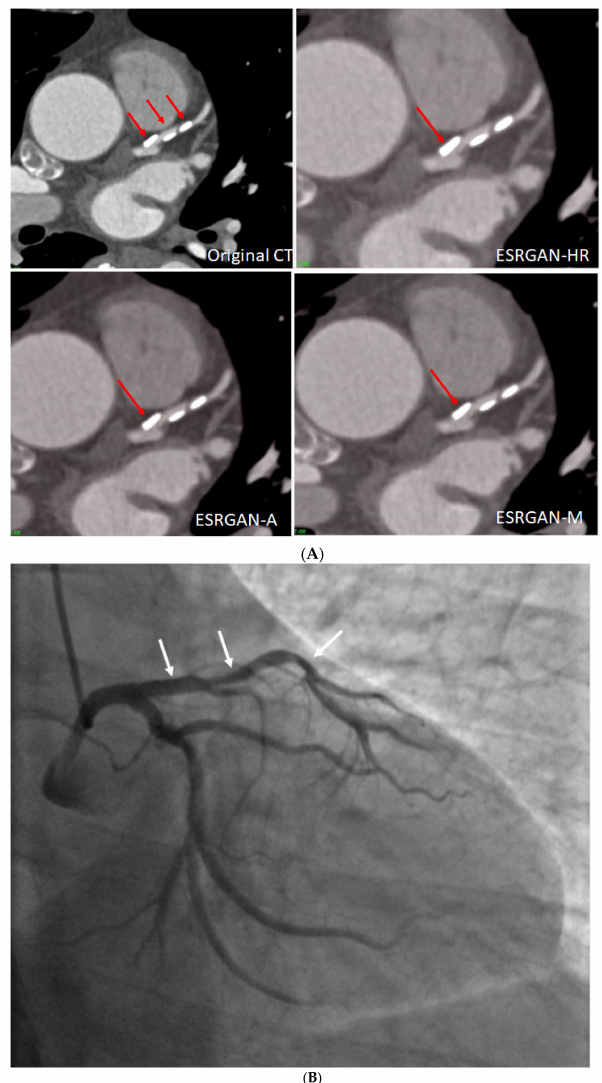
Figure 4. Multiple calcified plaques at the left anterior descending (LAD) artery in a 69-year-old man with coronary artery disease. ( A ): Comparison of the enhanced super-resolution generative adversarial network (ESRGAN)-processed images with the original coronary computed tomography angiography (CT) image in the assessment of coronary lumen stenosis caused by calcified plaques (arrows), with obvious improvement of lumen assessment, in particular, the ESRGAN-Median (ESRGAN-M) image in the assessment of the first plaque (long arrows). The measured mean stenosis was 63%, 44% and 86% at original CT, 58%, 39% and 83%, 56%, 37% and 83%, and 48%, 36% and 80% corresponding to ESRGAN-High Resolution (ESRGAN-HR), ESRGAN-Average (ESRGAN-A) and ESRGAN-Median (ESRGAN-M) images, respectively. ( B ): Invasive coronary angiography confirmed no significant stenosis at the LAD with corresponding diameters being 23%, 37% and 28% (arrows), respectively. ESRGAN-M images reduced the false positive rate by 33% when compared to the original CT and other two processed